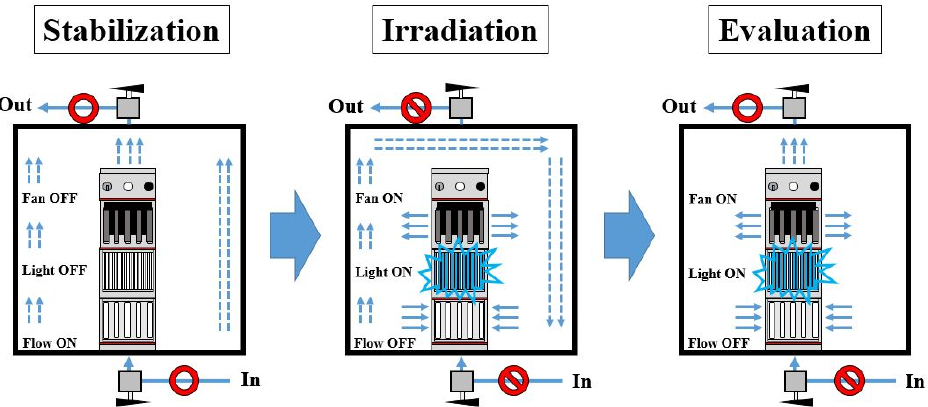
Figure 4. Schematic image of the three-step process for the evaluation of the photocatalytic air purifier performance (reactor #2) with a simulation of a real case of an indoor environment without air circulation.